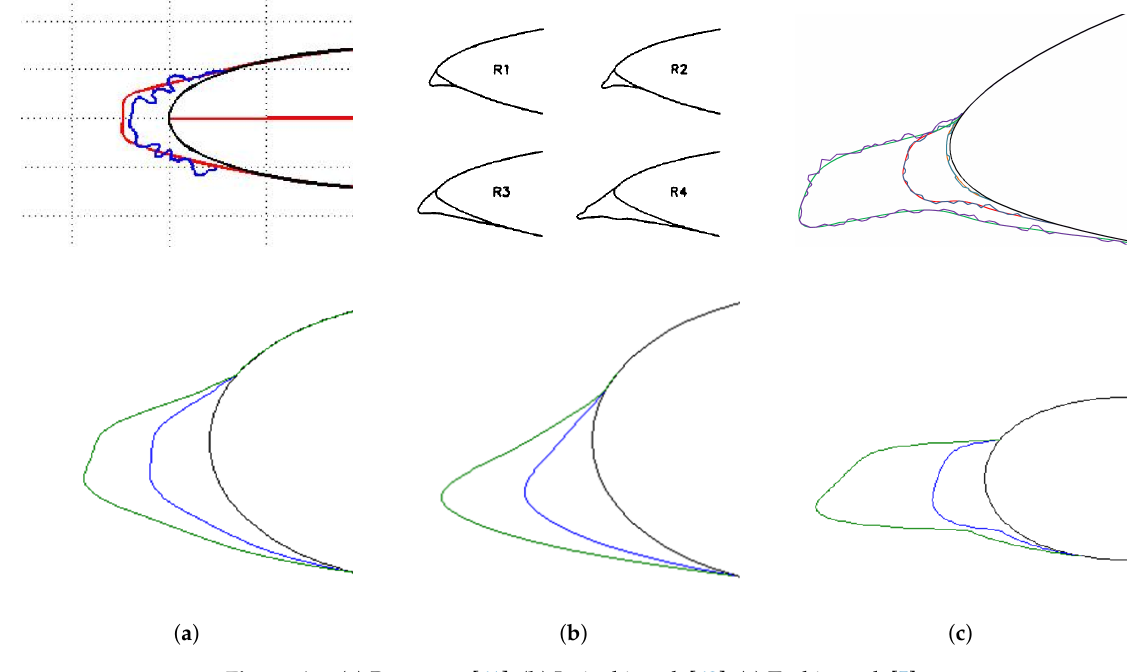
Figure A1. ( a ) Brouwers [61]; ( b ) Jasinski et al. [62]; ( c ) Turkia et al. [5].